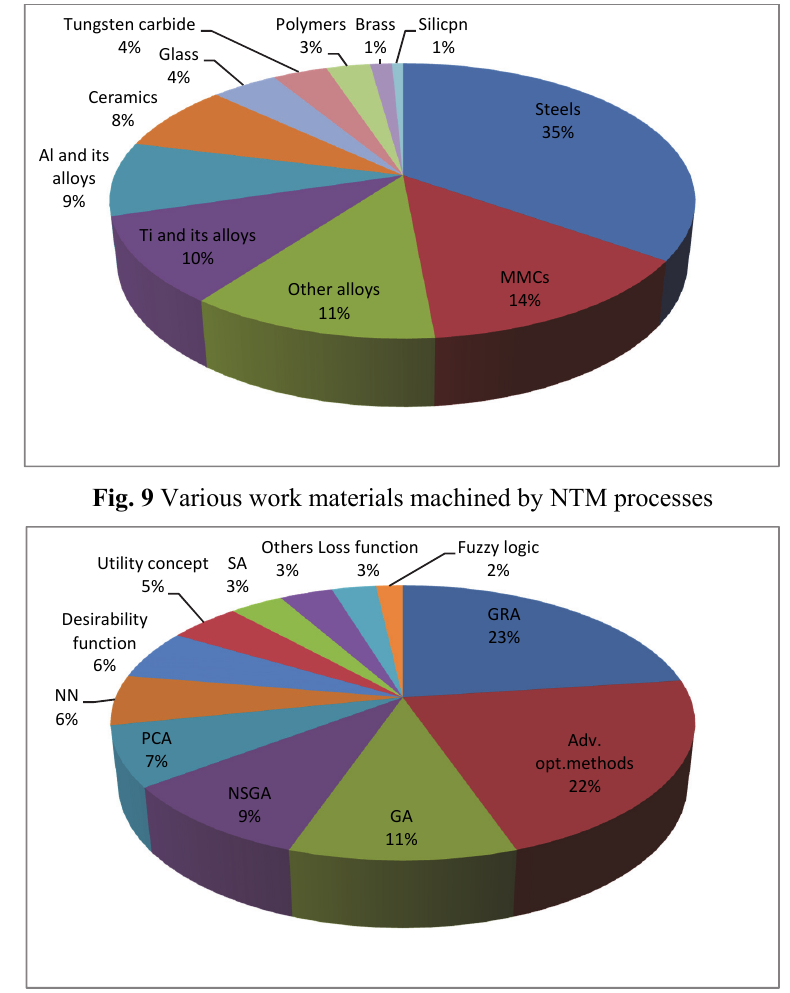
Fig. 10 Optimization tools adopted for parametric optimization of NTM